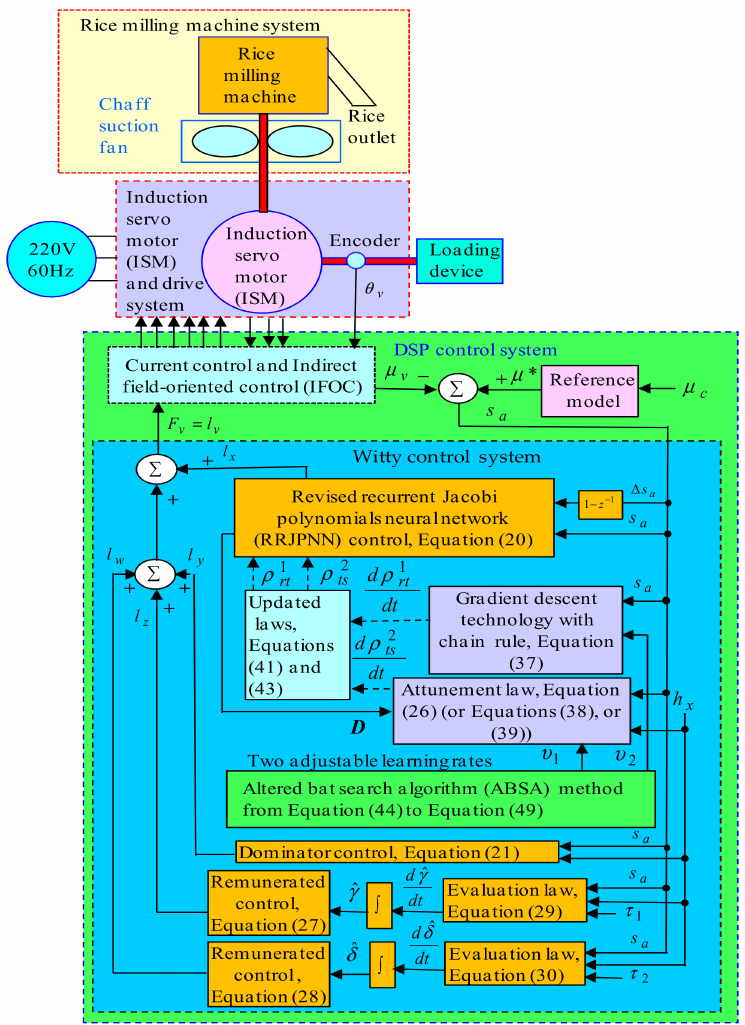
Figure 3. Control frame of witty control